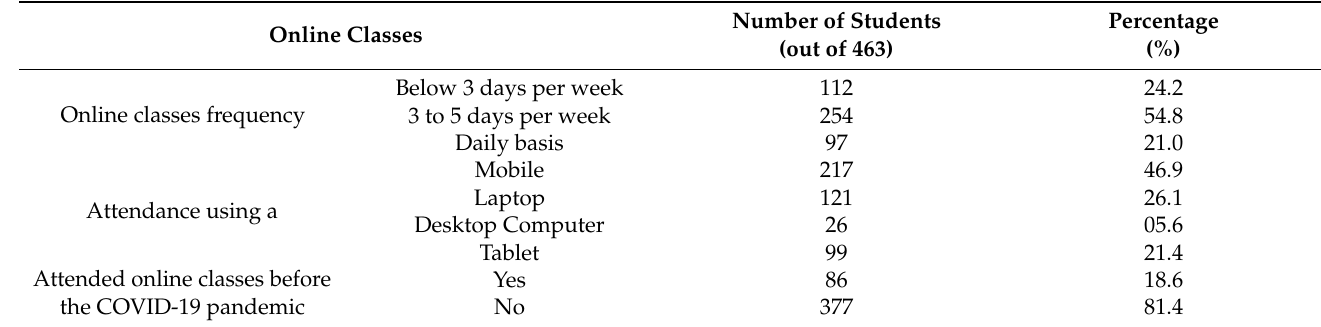
Table 5. Online classes attendance frequency, used device, and familiarity.